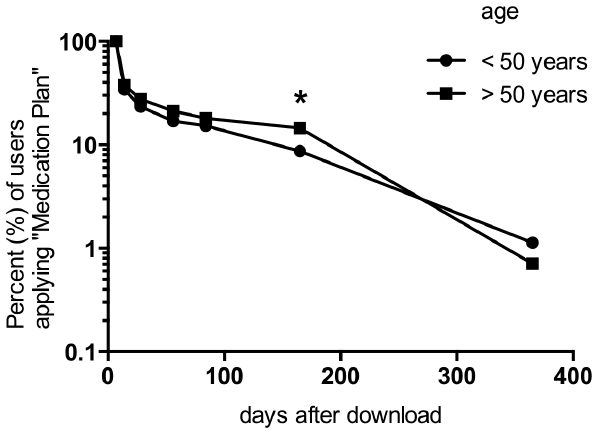
Figure 3. 1095 regular users (defined as applying "Medication Plan" at least once a week for at least 28 days) specified their age. At 28 days after download 23% (124/530) of users , 50 years and 28% (156/565) of users . 50 years were still using the application at least once a week (p . 0.05). The proportion of older individuals using ‘‘Medication Plan’’ at 165 days was significantly higher ( , 50 years: 9% (46/530) and . 50 years 15% (82/565); p , 0.004*). After 365 days only 1% of regular users , 50 years (6/530) as well as . 50 years (4/565) were using the application.